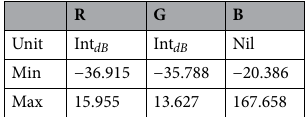
0 values in different bands.